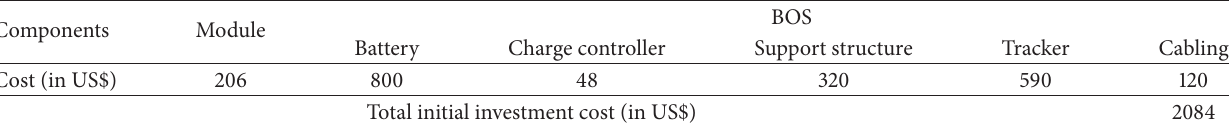
Table 6: Cost of various components of LCPV system ( ≈ 1kW with the current market price) ∗ .